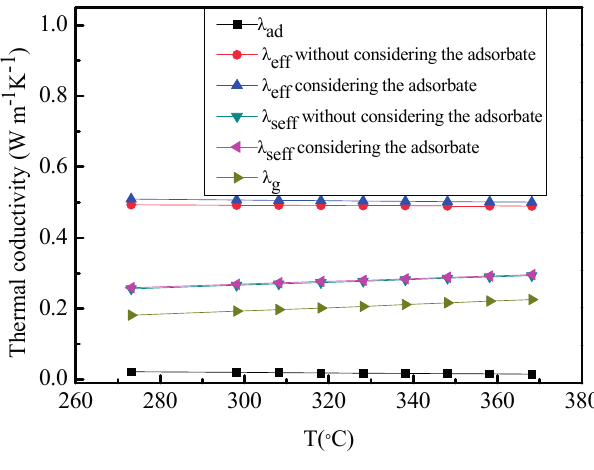
Figure 8. Varying thermal conductivity at different temperatures and 10 MPa.